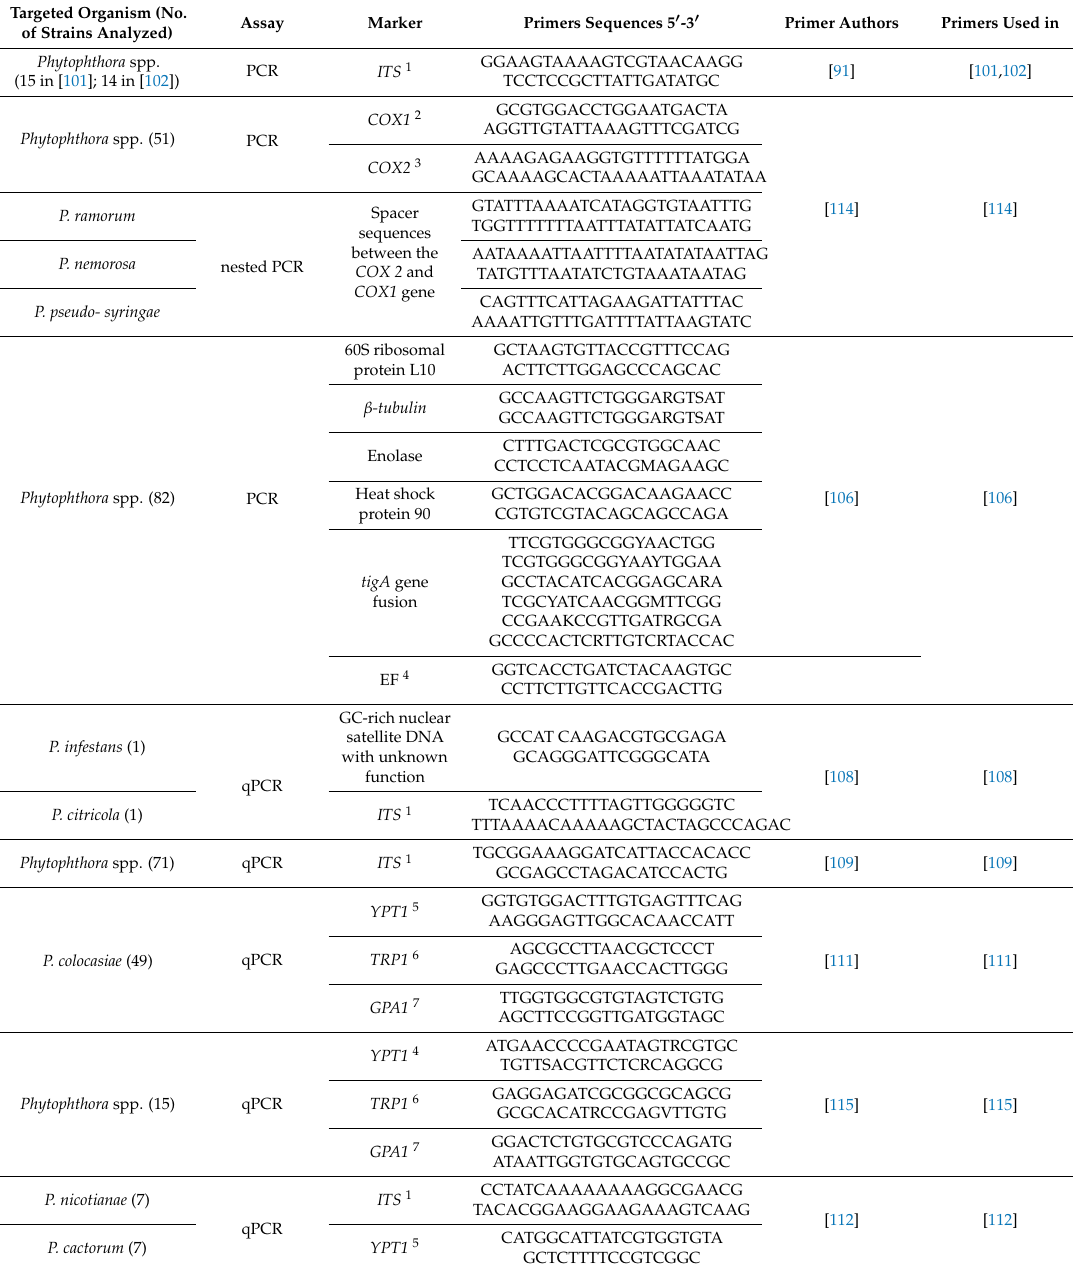
Table 3. Selected primers designed for molecular analysis of Phytophthora